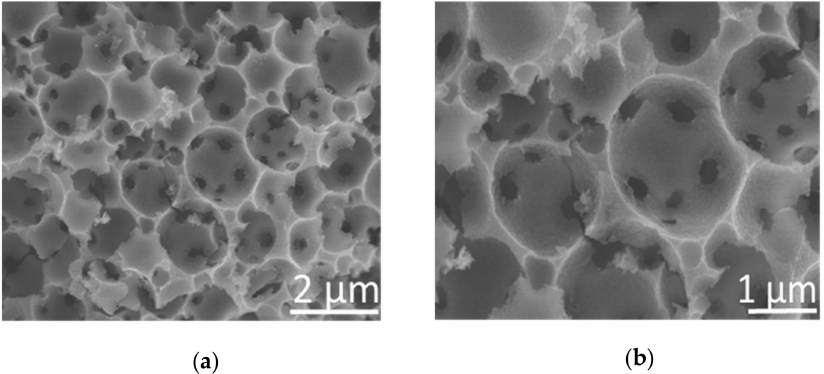
Figure 1. ( a ) Scanning Electron Microscopy images of the macro-mesoporous CeO 2 . ( b ) Close inspection that evidences the interconnected